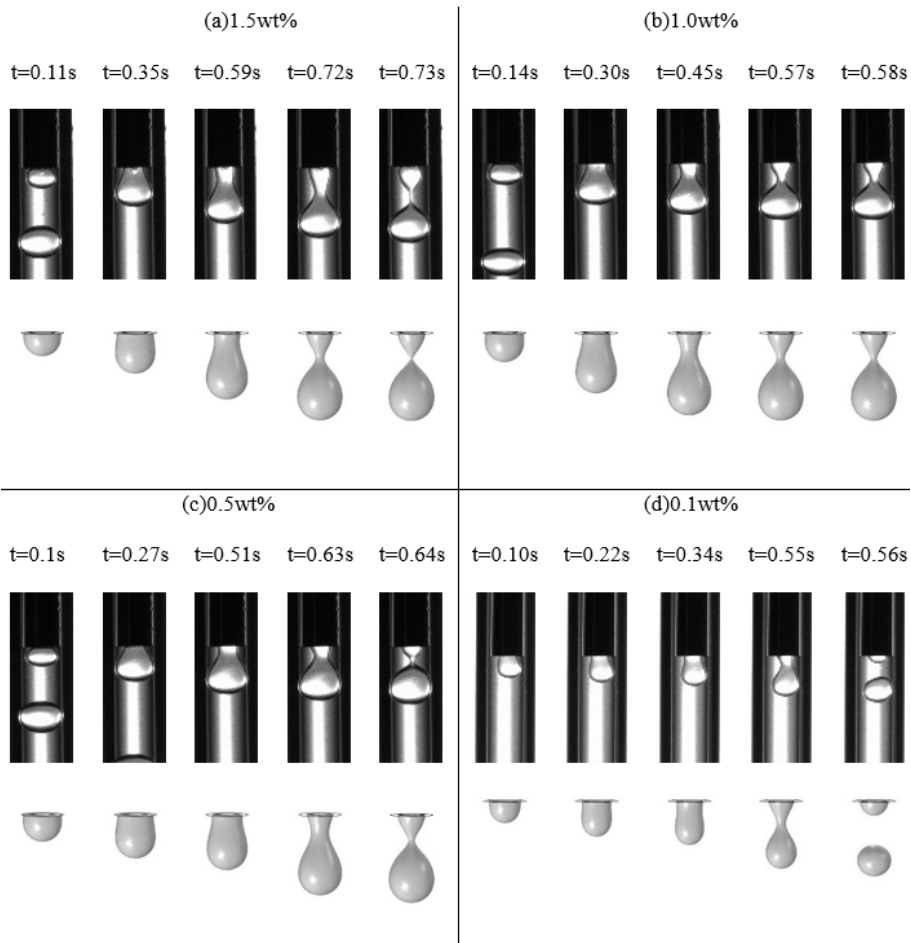
Figure 5. The comparison between the experiment results and numerical simulation results ( Q d = 2 mL/h, Q c = 20 mL/h). ( a ) 1.5 wt%, n 1 = 0.437 ( b ) 1.0 wt%, n 2 = 0.162 ( c ) 0.5 wt%, n 3 = − 0.567 and ( d ) 0.1 wt%, n 4 = − 0.583.